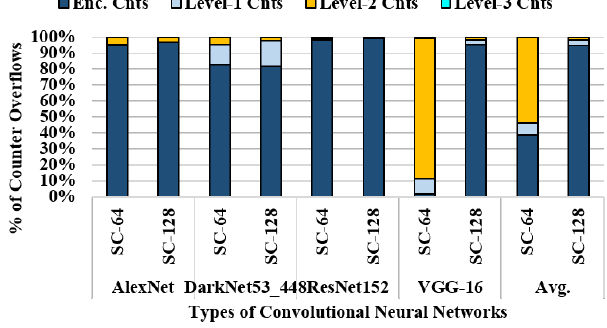
Figure 8. Counter overflow breakdown for split counter-64 and split counter-128.